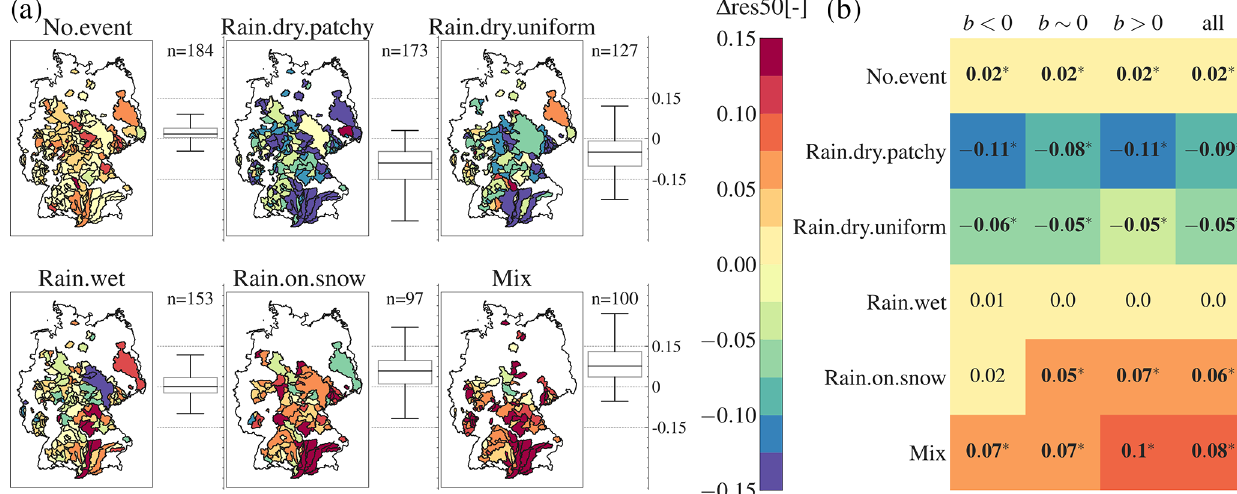
Figure 5. Median deviations of nitrate concentrations from the long-term C – Q relationships ( (cid:49) res50). (a) (cid:49) res50 values of different event types for each catchment. On the right-hand side of each map, boxplots show the distribution of (cid:49) res50 values across catchments for each event type (box limits represent the interquartile range and whiskers correspond to the 5th and 95th percentiles). (b) Heatmap of (cid:49) res50 values averaged across different groups of catchments, considering all nitrate data for each event type and No.event. The first three columns of the heatmap correspond to one of the long-term export patterns (i.e., dilution, slope b < 0, neutral, slope b ∼ 0, and enrichment, slope b > 0) and the fourth column corresponds to all study catchments. Bold font and ∗ indicates significant differences (Kruskal–Wallis test, p < 0.05) between median deviations across catchments for each event type and median deviation across catchments of all nitrate samples.